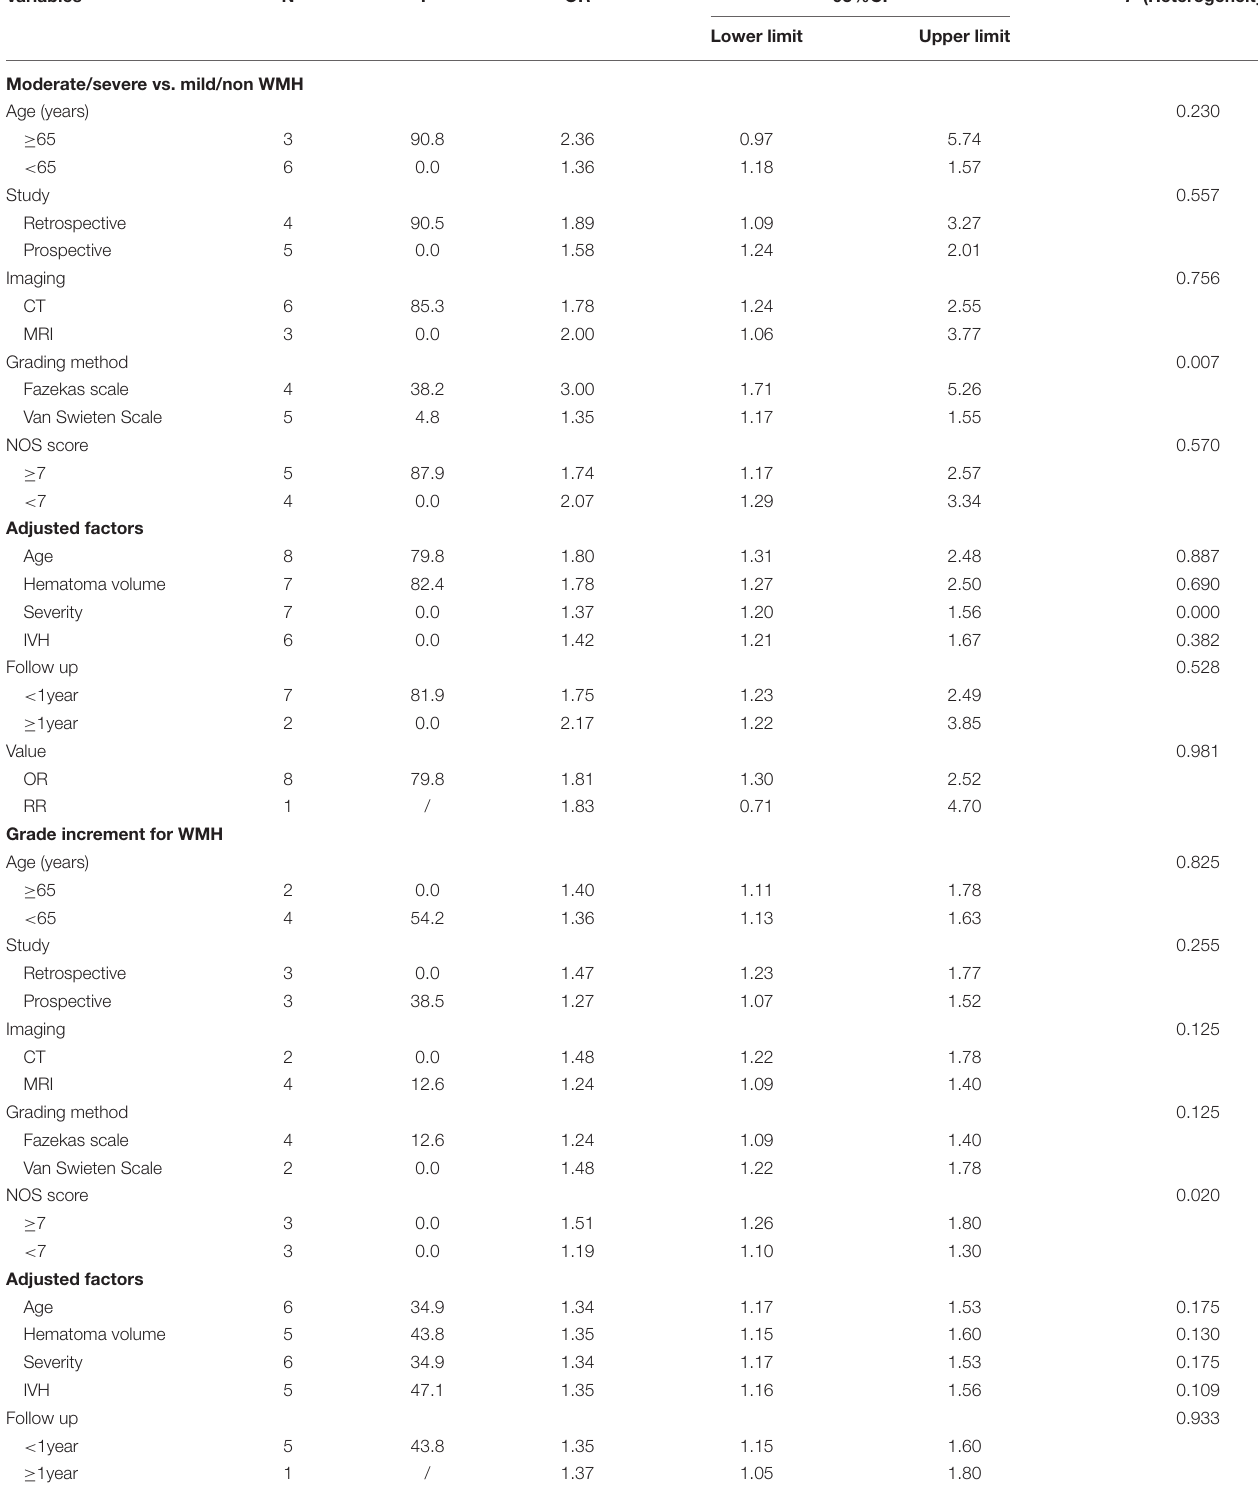
TABLE 3 | Subgroup analysis of WMH and functional outcomes. Variables N I 2 OR 95%CI P (Heterogeneity)